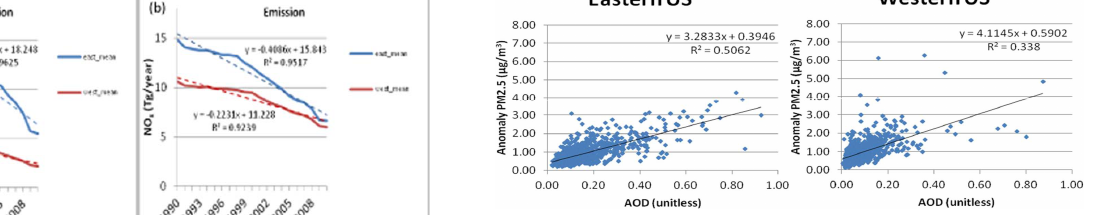
Fig. 3. Annual anomalies of SO 2 (left) and NO x (right) emission for each regional mean (solid colored line) together with their LSF (dash line). The best-fit equation and coefficient of determination ( R 2 ) are given at right in each panel.